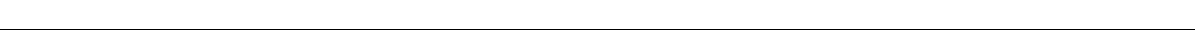
Fig. 1 CD271 correlates with an invasive signature and decreased proliferation. a Scheme illustrating the experimental approach using human organotypic skin substitutes as the basis for a humanized in vivo melanoma model to study melanoma invasion. Human melanoma cells (M070413) stably expressing GFP are mixed with human keratinocytes (HKC) and seeded onto high-density type-I collagen hydrogels containing human dermal fi broblasts (HFB). This human dermo – epidermal skin equivalent is then transplanted onto immunocompromised rats. b Immuno fl uorescent staining of GFP and CD271 on sections of transplanted human organotypic skin substitutes ( M Melanoma, D Dermis). Scale bar 75 µ m. c After excision, cells were isolated from the skin equivalent and sorted for GFP and CD271 high and low populations. d Gene expression analysis of the CD271 high and low populations ( n = 2, Log2 ratio < − 0.6, > 0.6; FDR < 0.5). e Pathway analysis of the CD271 high vs. low population with MetaCore TM (http://thomsonreuters.com/en.html). f Selected genes with highest signi fi cance from the MetaCore TM analysis representing enrichment of the EMT, Cell Adhesion, ECM Remodeling, Cell Cycle, Upregulation of MITF in melanoma and other pathways. g – p Correlation of RNA seq. data from TCGA for CD271 with MITF, Tyrosinase (TYR), Melan-A (MLANA), PMEL, E-cadherin (CDH1), ZEB1, TWIST1, WNT5A, c-JUN, and AXL